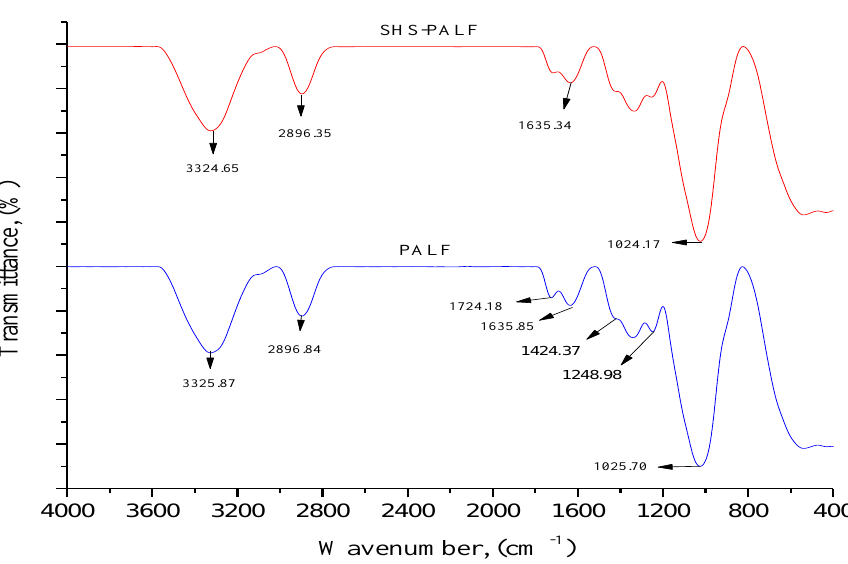
Figure 1. FTIR spectra of PALF and superheated steam-treated PALF (SHS-PALF).